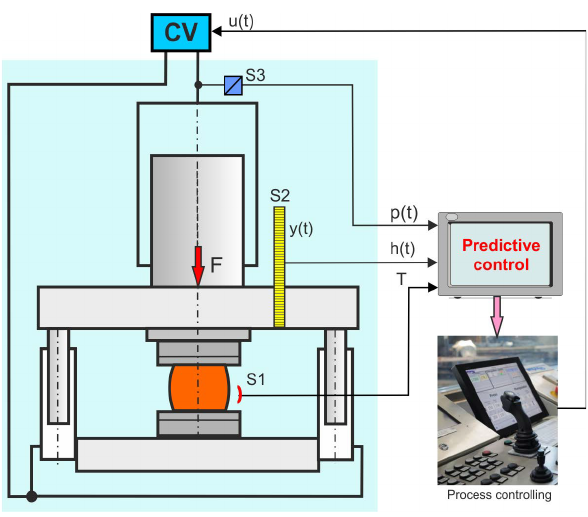
Figure 11: Schematic diagram of the predictive control of the 80 MN hydraulic press: S1 – infrared temperature sensor T , S2 – position transducer y ( t ) , S3 – pressure transducer p ( t ) , CV – control valve